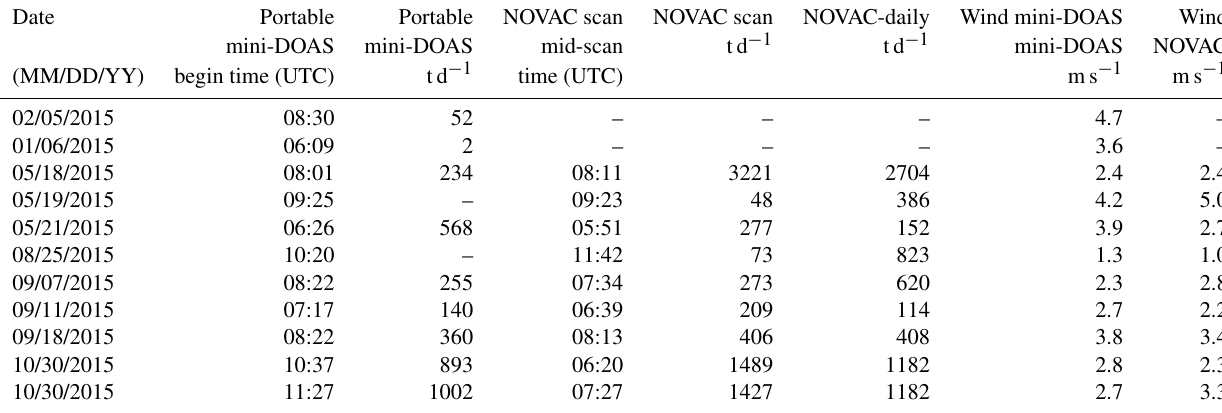
Table A2. Summary of mini-DOAS and NOVAC scan measurements.